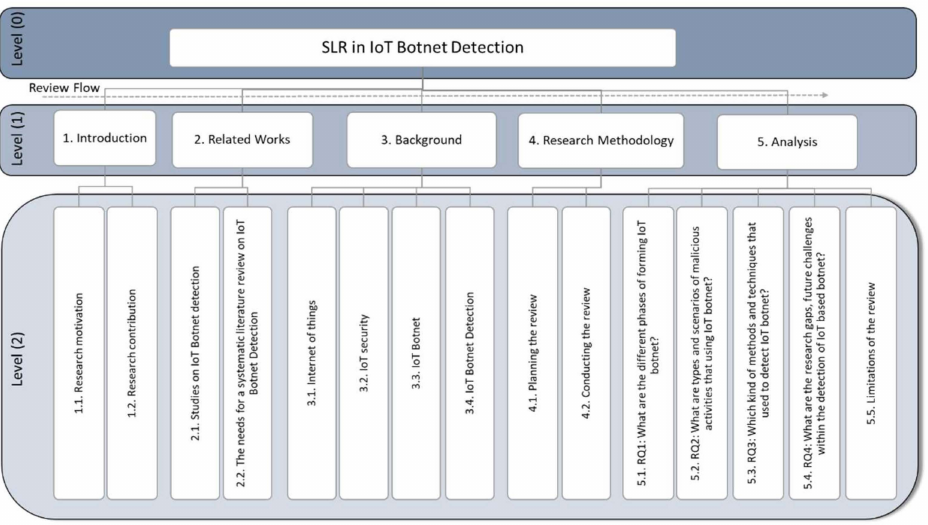
Figure 1. The SLR structure from the main topic in level 0 to the subsections in level